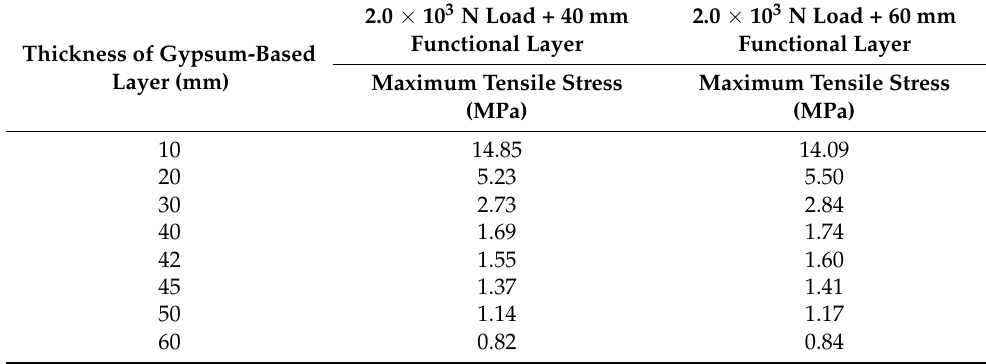
Table 3. Corresponding table of thickness and maximum tensile stress of gypsum-based layer.